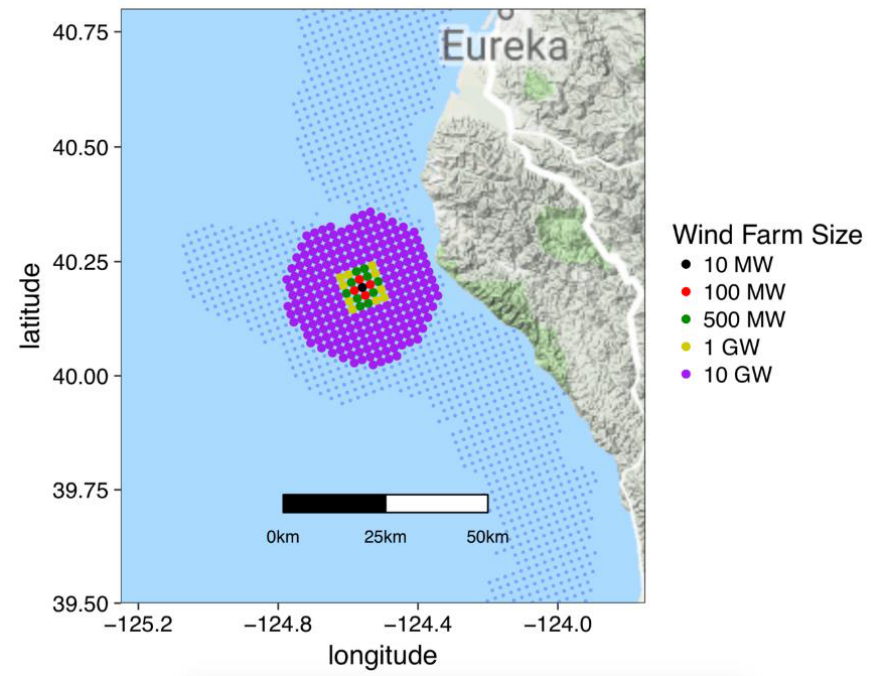
Figure A3. Wind farm sizes in Cape Mendocino ranging from 10 MW to 10 GW. Larger capacities also encompass the points used to display previous capacities in other colors. Table A3. Number of data points used to represent various wind farm capacities.